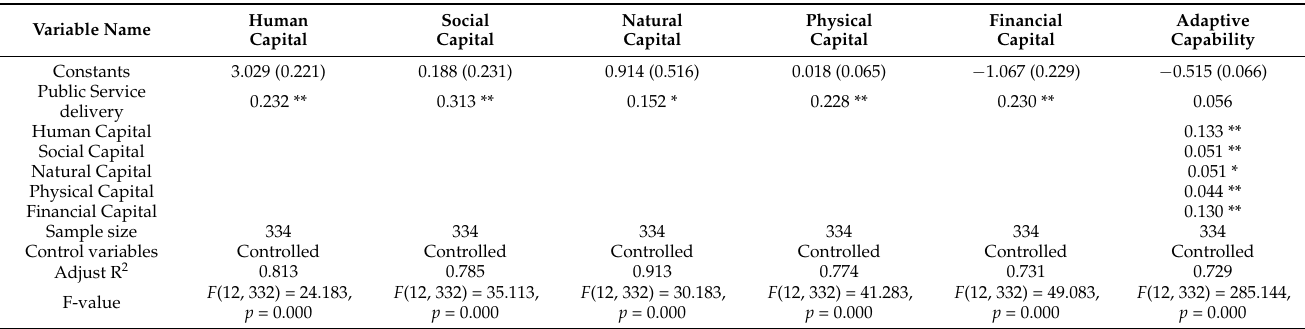
Table 6. Results of the mediation effects model.